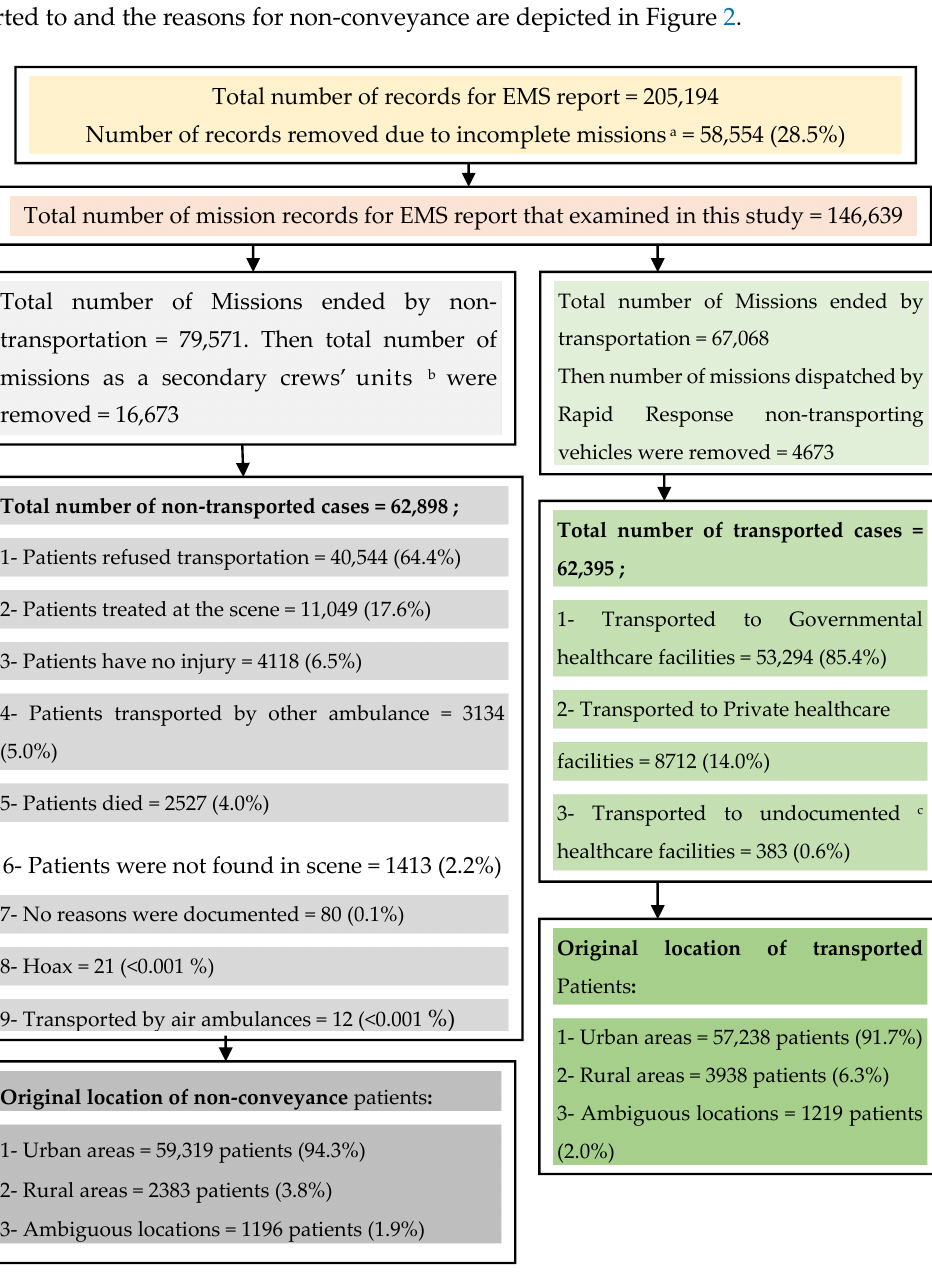
Figure 2. Flow Diagram for All missions in the Rural and Urban Areas of Riyadh Province, Saudi Arabia, during 2018 that either Transported the Patients to the Healthcare Facilities or Ended as a Non-conveyance Circumstances due to Multiple Reasons. a The decision made by the call center to stop the dispatched ambulance from continuing their mission toward the scene due to cancellation by a caller, wrong geographical location, false alarm, or nominate far crews to a patient. b Secondary crews are the qualified EMS personnel who dispatched to the scene and arrived afterward by another ambulance vehicle to support the first crews who arrived earlier. c Hospitals or primary care centers that were not documented by the Saudi Red Crescent database when the crews had arrived at them. Table 2. Description of the Total Missions Dispatched by Sex, Age category and Geographical Area. Category